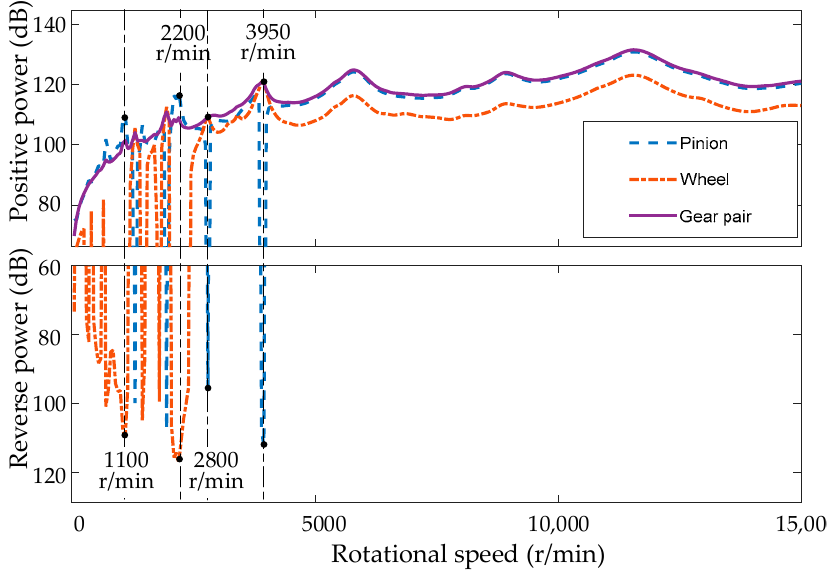
Figure 7. Excitation power flow of gear pair—location path.